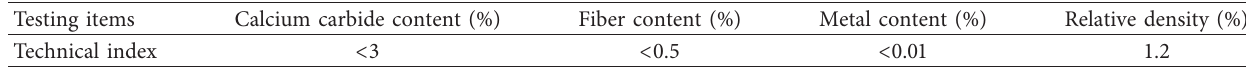
Table 2: Physical and technical index of rubber powder.